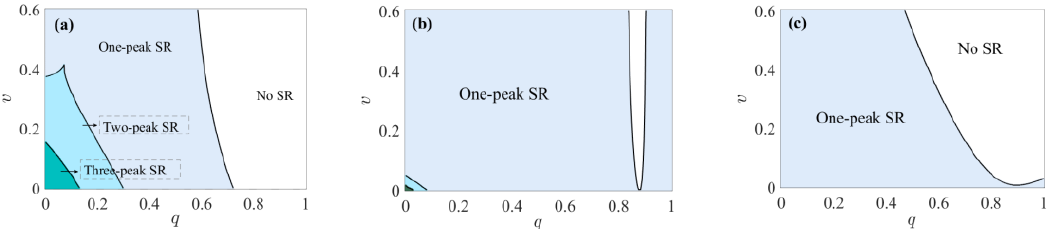
Figure 6. Dependence of bona fide SR on combined parameters ( v , q ) under different noise intensity. ( a ) ∆ 2 = 1, ( b ) ∆ 2 = 0.1, ( c ) ∆ 2 =